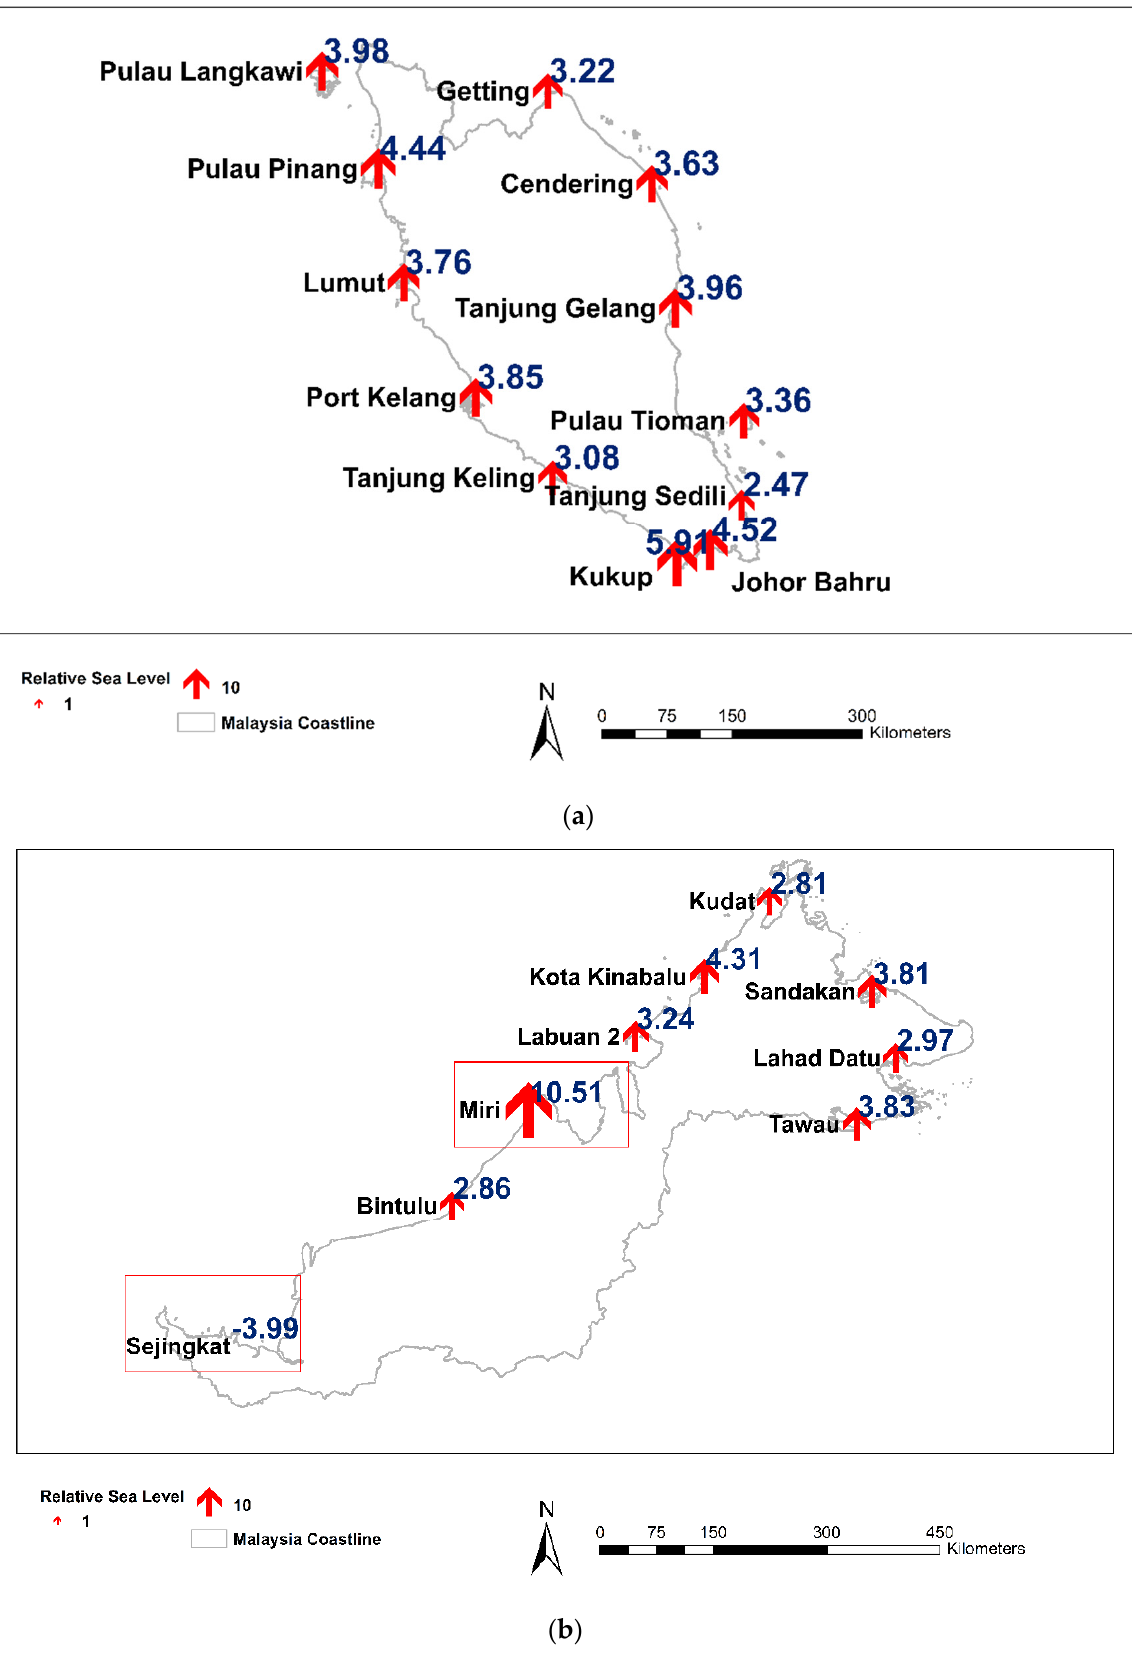
Figure 4. Relative sea-level trends at ( a ) the Peninsular Malaysia coastline and ( b ) Sabah and Sarawak. The values estimated for the stations in red rectangles were uncertain due to the unreliability of the tide-gauge record.